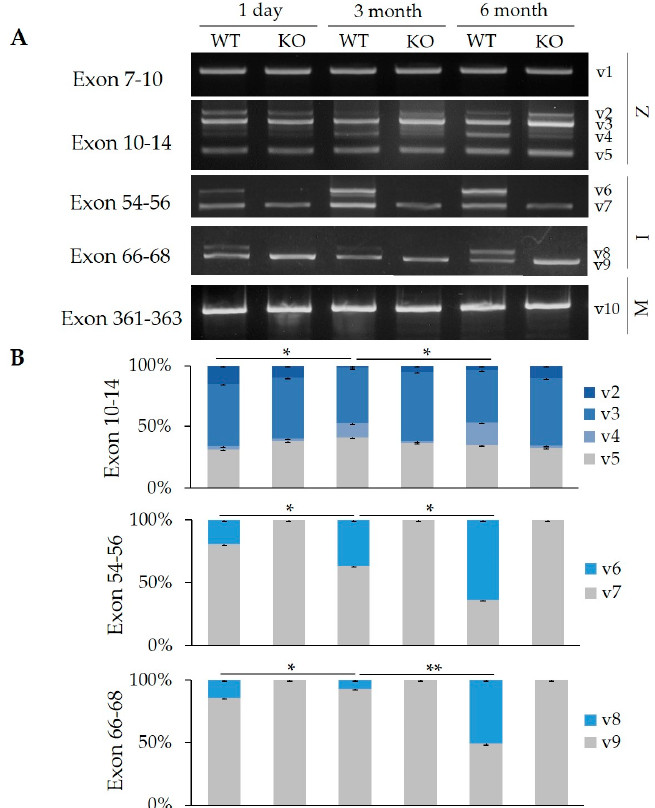
Figure 1. Splicing of Z-, I-, and M-band titin during development. ( A ) RT-PCR results with